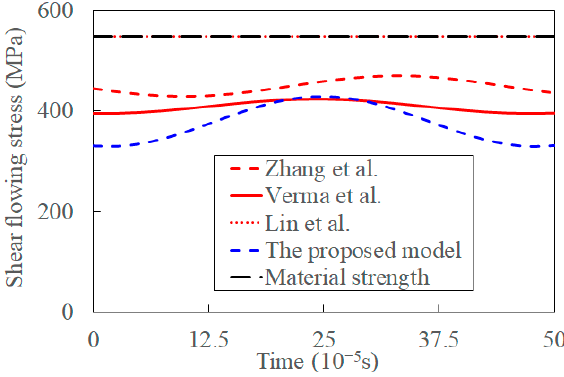
Figure 14. The shear is flowing stress in ultrasonic vibration-assisted orthogonal cutting. With the increase of amplitude, the transient and average shear flowing stresses decrease, and the fluctuation of it increases, as shown in Figure 15. The deformation in the shear band increases, and UVC formation process is more changeable by the increased synthetic cutting velocity with the increased vibration amplitude. This is verified by comparing experimental chip morphology under different amplitudes [65]. The averaged shear flowing stress decreases when the temperature of the shear band increases [16]. The decreased fluctuation of shear flowing stress implies that the increased amplitude promotes the separation of materials and fracture of chips by the shear angle in the UVC process. The shear flowing stress increases with un-deformed depth as the deformation area of the primary shear zone increases—the average deformation of the shear band and average thermal softening decrease [66]. Thus, the shear flowing stress, as well as its fluctuation, increase with the increase of feed rate, as shown in Figure 16.